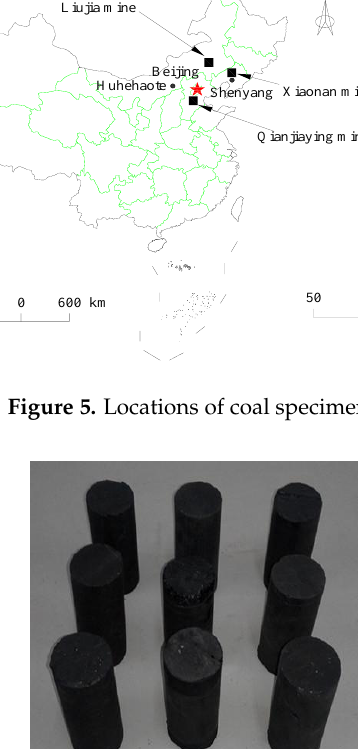
Figure 4. Micromeritics ASAP 2020.